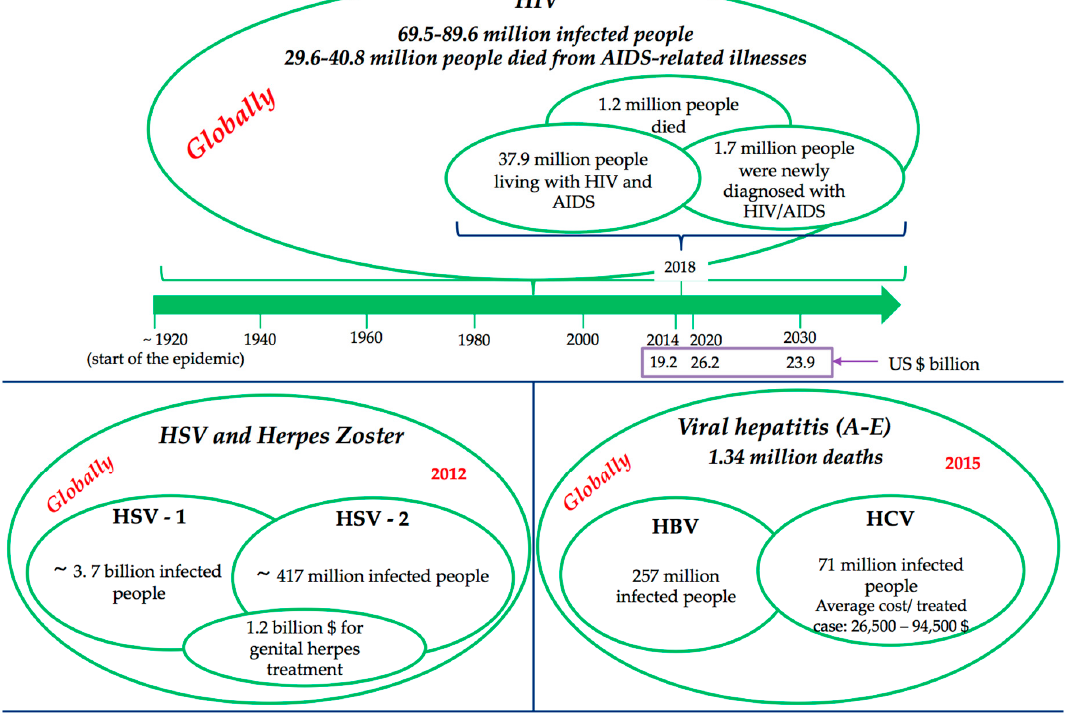
Figure 1. Global impact of viral diseases.